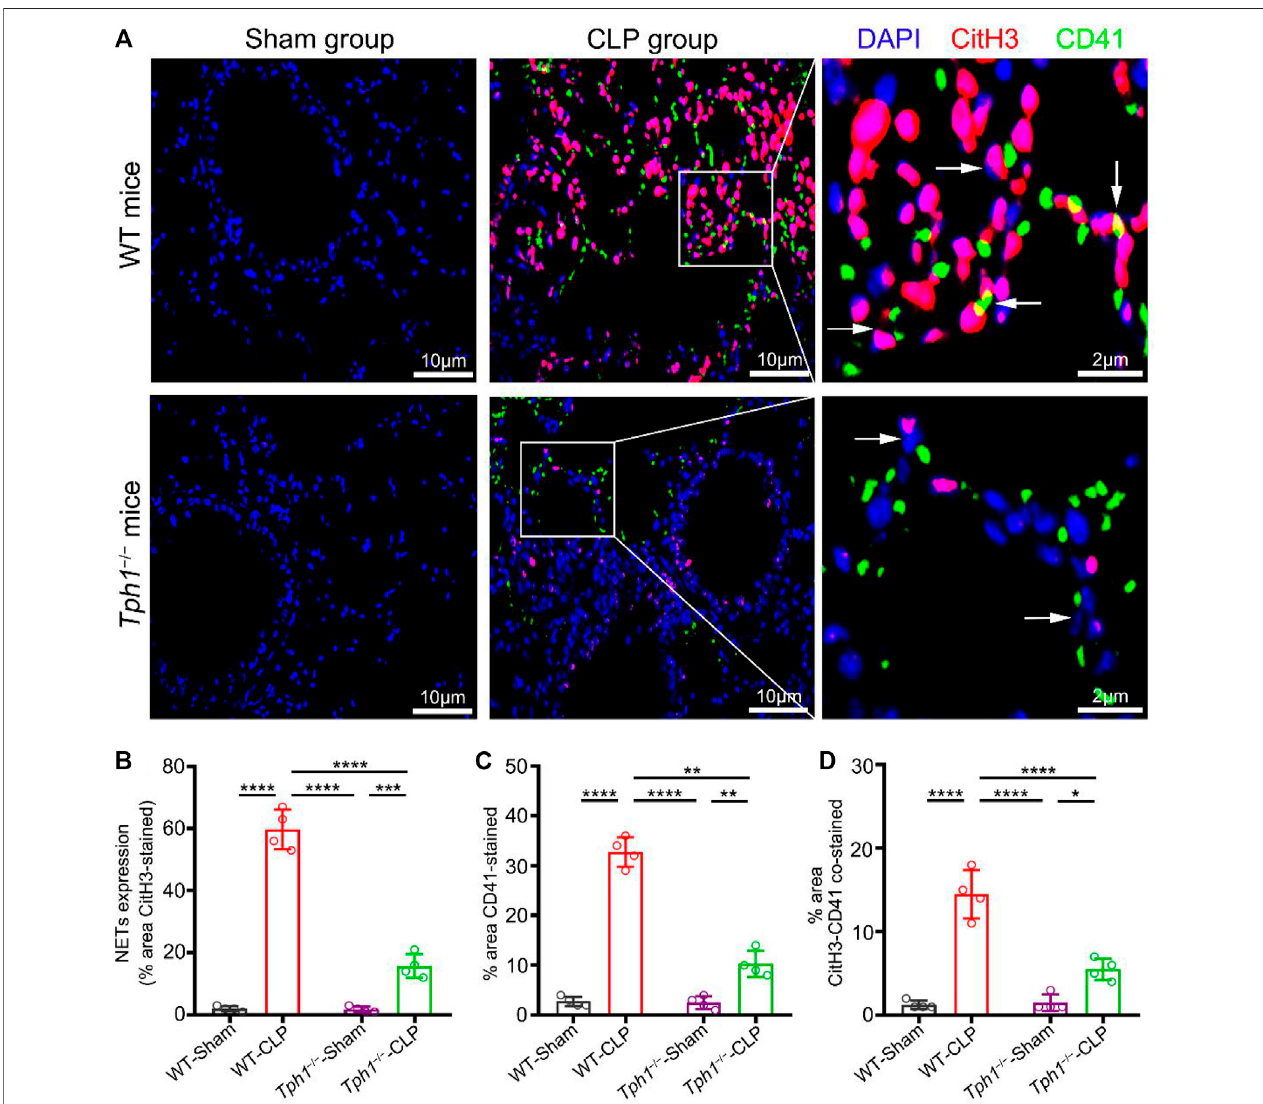
FIGURE 3 | Peripheral 5-HT de fi ciency inhibits the accumulation of platelets with NETs in the lung of septic mice. Both WT and Tph1 − / − mice (male, 6 – 8 weeks) were selected and randomly divided into sham and CLP groups. The mice were sacri fi ced 12 h after surgery, and lung specimens were collected and co-stained with CD41,CitH3,andDAPI fl uorescentantibodies.TheaccumulationofNETswasdetectedbyimmuno fl uorescencemicroscopy.Lungspecimensfromshammiceshowed little accumulation of platelets and NETs. Lung specimens from WT CLP mice group showed a large number of accumulation of platelets and NETs, while lung specimensfrom Tph1 − / − CLP mice showed asigni fi cantdecrease oftheaccumulationofplateletsand NETs. (A) Representativeimages oftheaccumulation ofplatelets and NETsinthelungofsepticmice. (B) AnalysisofNETexpression inmicelungspecimens. (C) Analysisofthepercentage ofCD41-stained lungspecimensinmice. (D) Analysis of the percentage of CitH3 – CD41-stained lung specimens in mice. For each group: n (cid:2) 4. *p < 0.05, **p < 0.01, ***p < 0.001, and ****p < 0.0001.